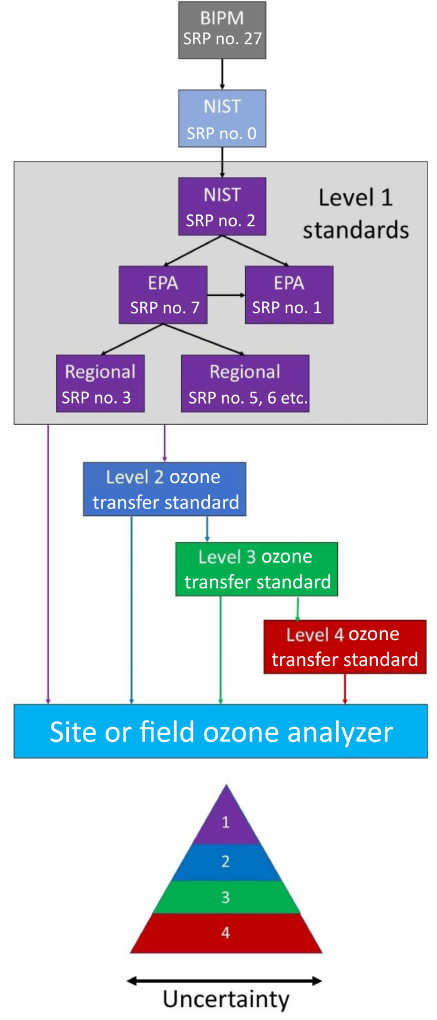
Figure 1. U.S. EPA ozone transfer standard